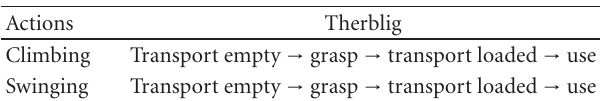
Figure 1: A unit of linguistic thought and playing action.